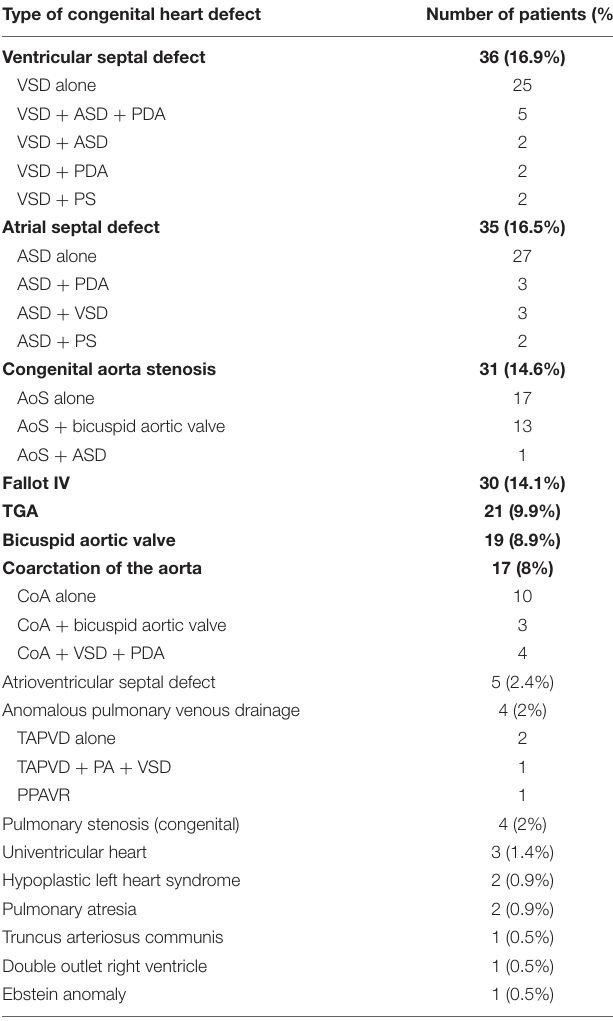
TABLE 1 | The distribution of different types of congenital heart defects among patients ( N = 212). Type of congenital heart